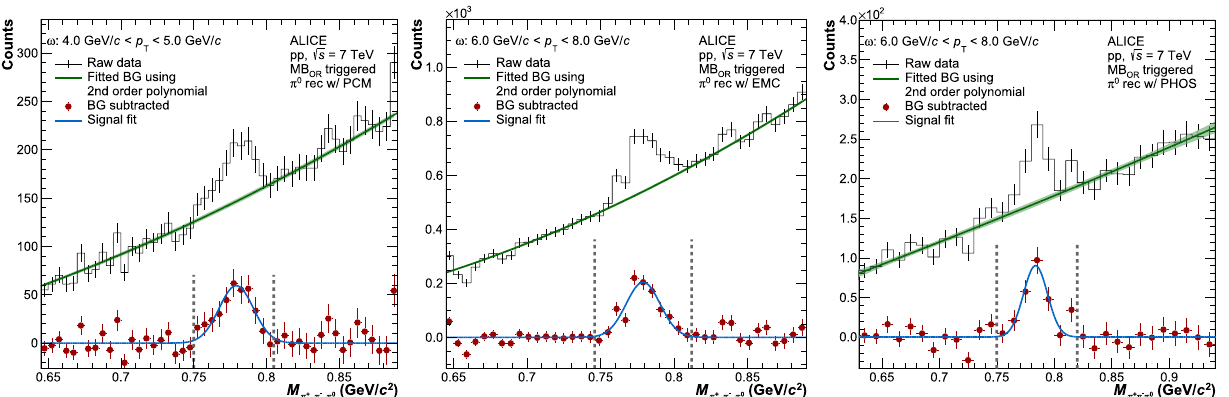
Fig. 1 Invariant mass of π + π − π 0 candidates shown in the vicinity of the nominal mass of the ω meson for indicated p T -ranges for π 0 reconstruction with PCM (left), EMC (middle) and PHOS (right). The second order polynomial used for the background description is shown with a band denoting the statistical uncertainties of the fit. The points